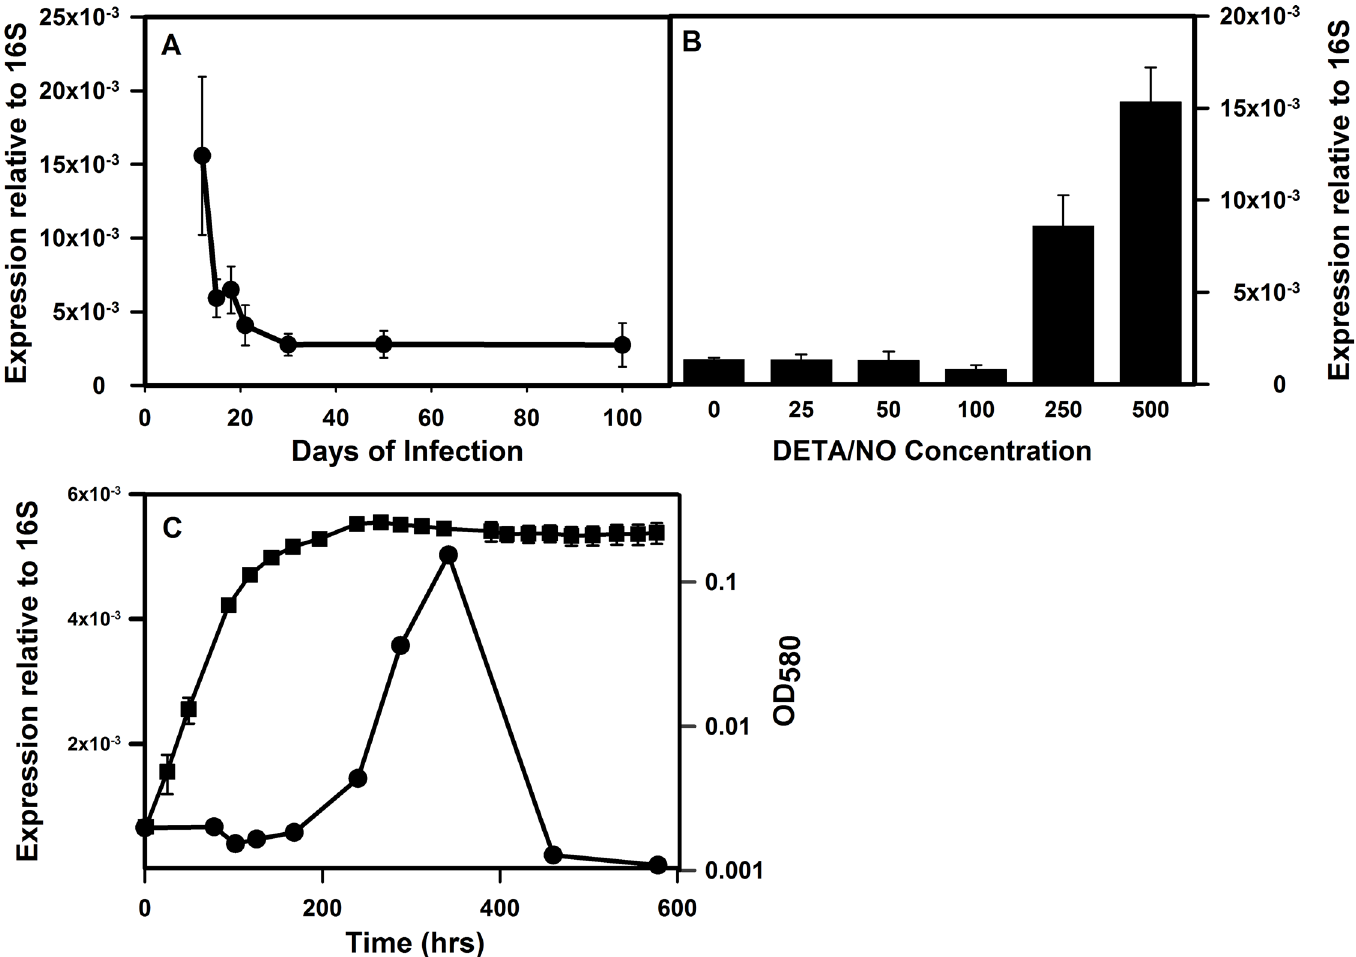
Fig 4. Transcriptional analysis of ald in vivo , and in response to stress conditions in vitro . (A) Expression of ald in the lungs of mice. Lungs were harvested from mice at the indicated time points post-infection. Total RNA was extracted and quantitation of bacterial transcripts was performed. Shown is the mean ( ± standard deviation) of normalized mRNA copy numbers relative to 16S rRNA from three mice at each time point. (B) Expression after exposure to the NO donor DETA/NO. (C) Expression of ald during extended incubation in the Wayne model. Circles indicate expression of ald relative to the 16S RNA, and squares indicate the optical density of the culture at 580